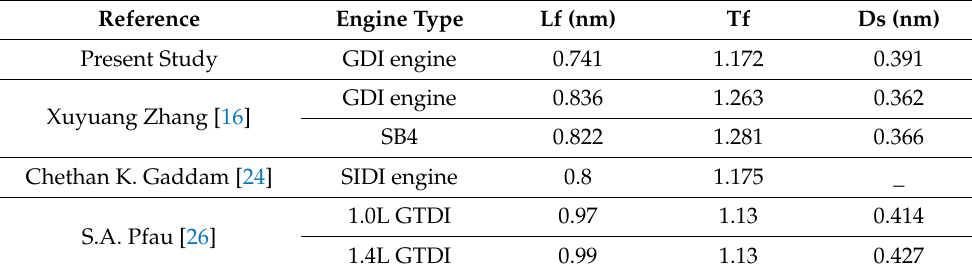
Table 2. Summary of the nanostructure of GDI soot particles in previous